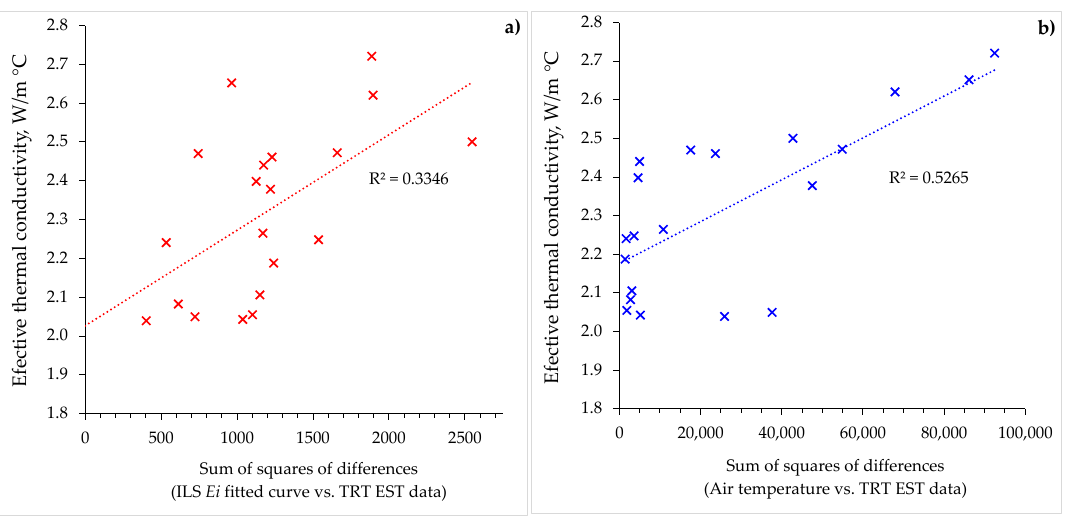
Figure 11. Example of fitting measured EST data with the infinite line source equation and two different values of thermal conductivity (the first obtained from the TRT period, and the second from the recovery period) for a case of 71 W/m and CXC setup.